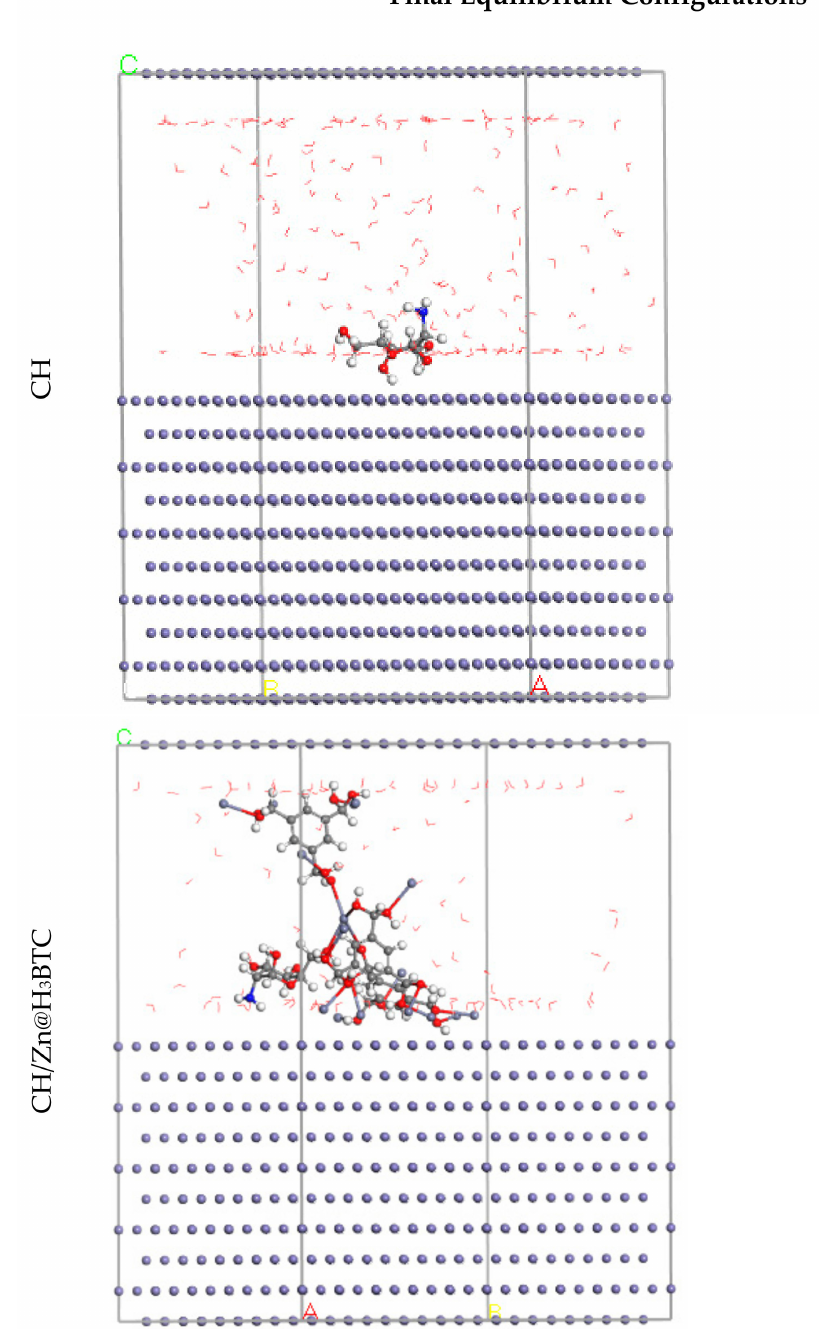
Figure 15. The most suitable configuration for adsorption of the monomer structures of CH and CH/Zn@H 3 BTC on Fe (1 1 0) substrate obtained by adsorption locator